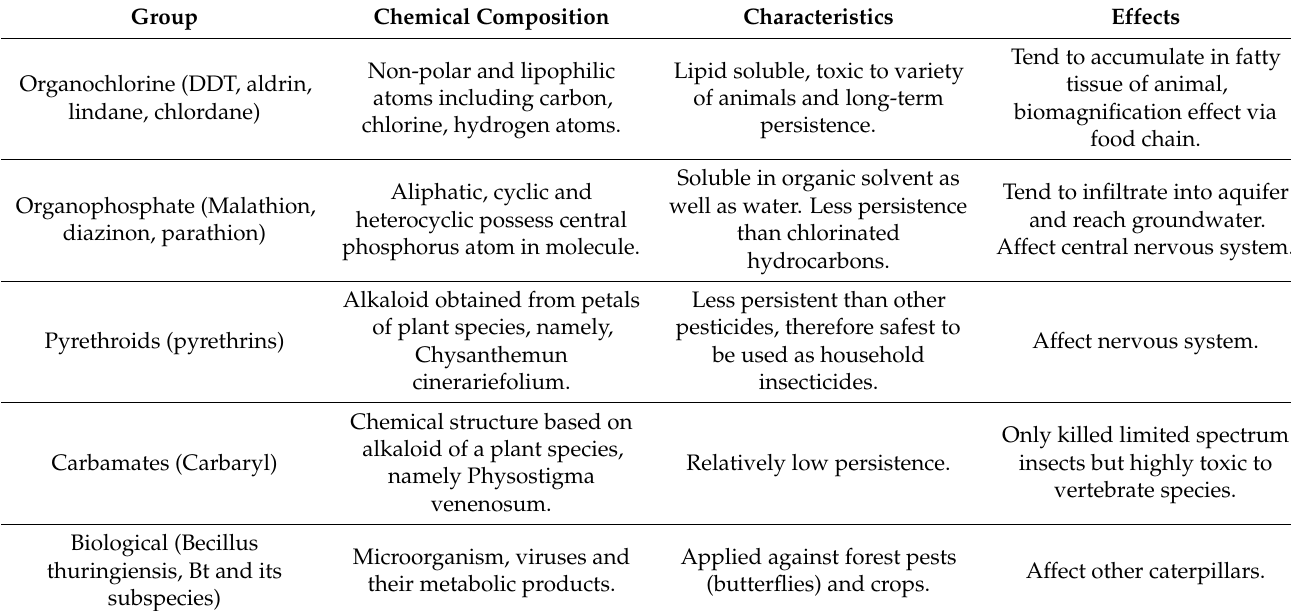
Table 2. Pesticide classification according to chemical composition and provided with some of their general characteristics [4]. Group Chemical Composition Characteristics